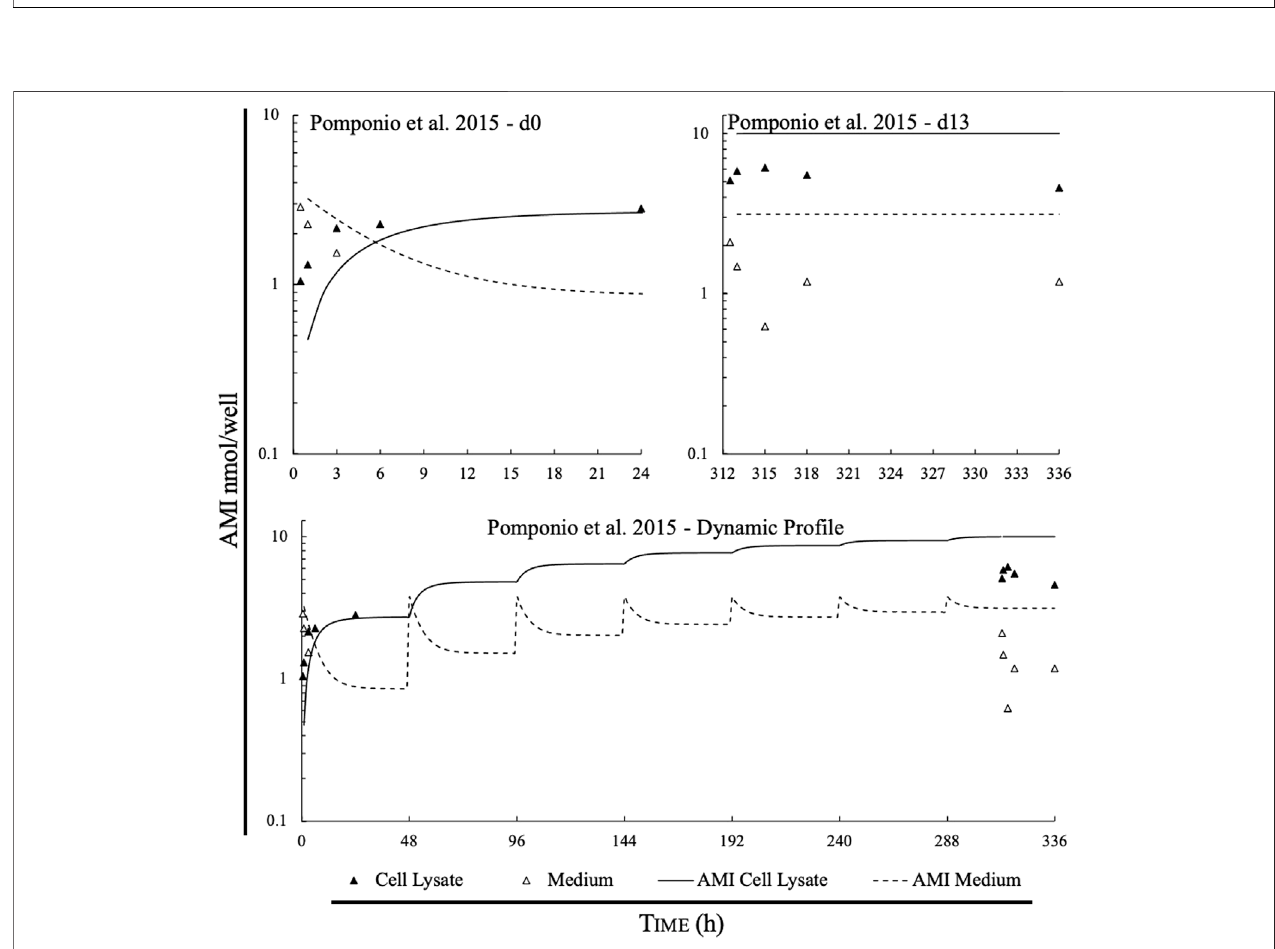
Frontiers in Toxicology |